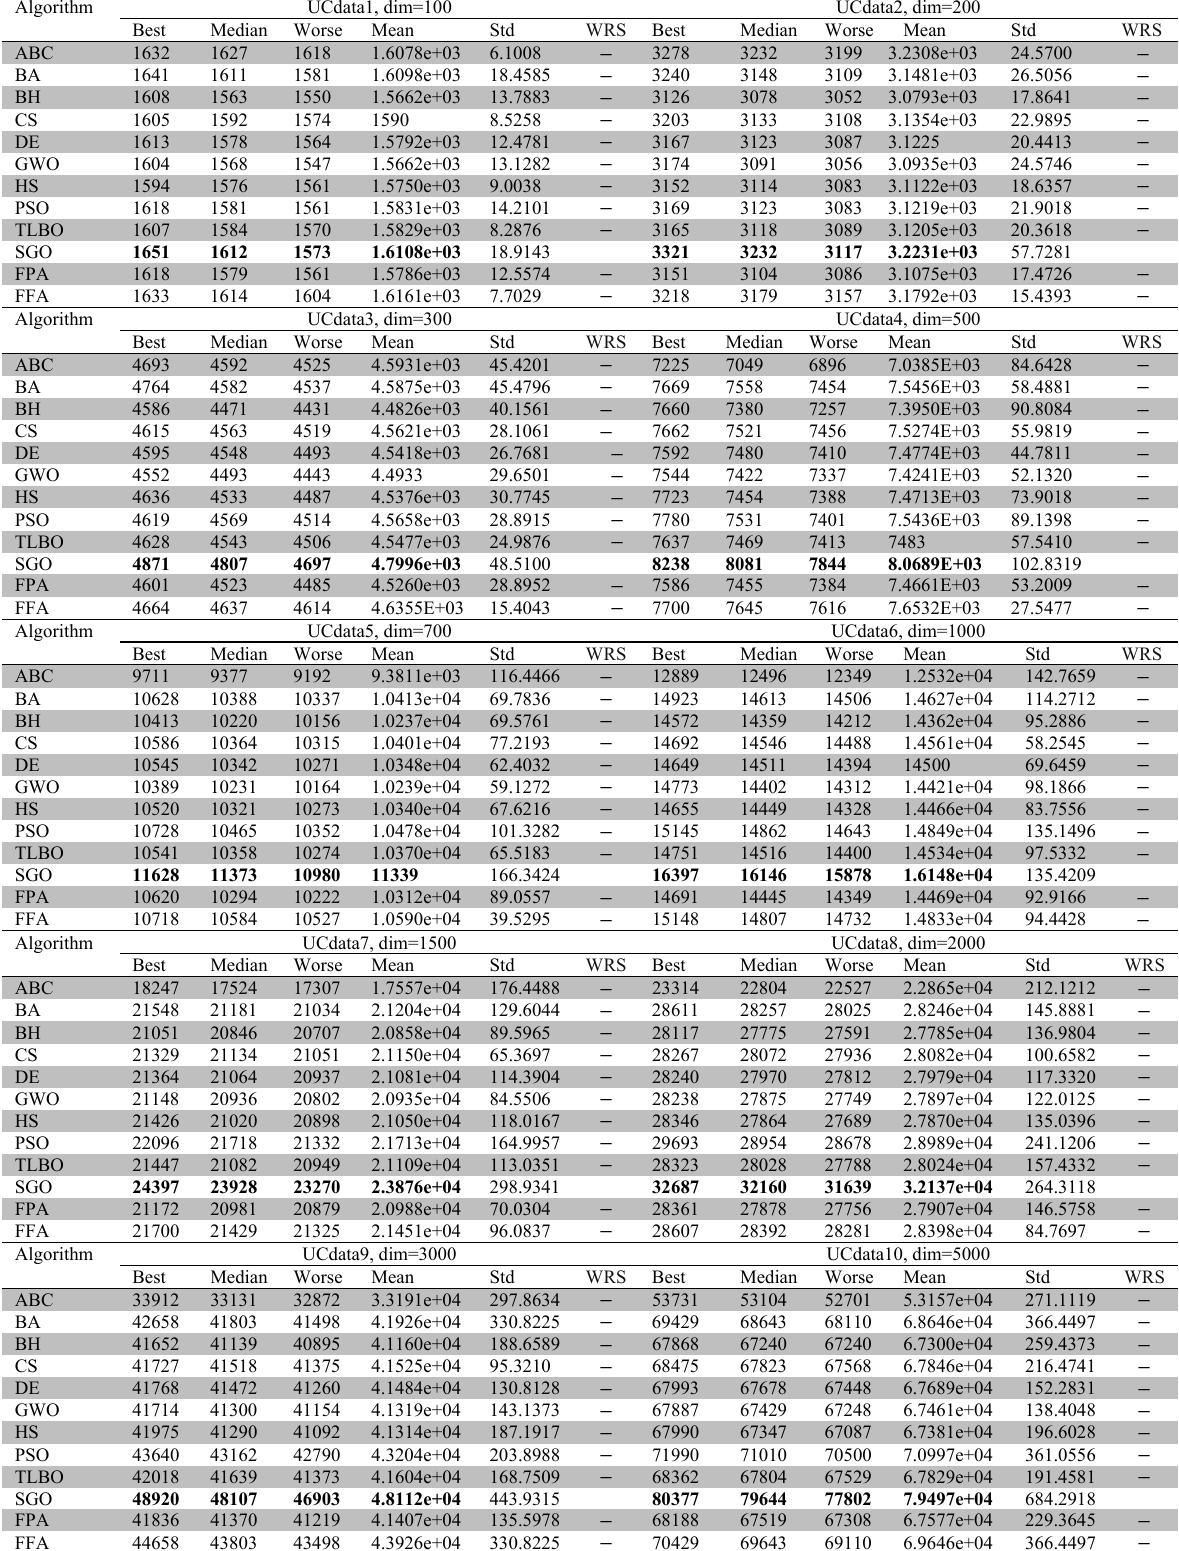
Results of UC data high dimensional 01knapsack problem , 30 different runs, 200 generation